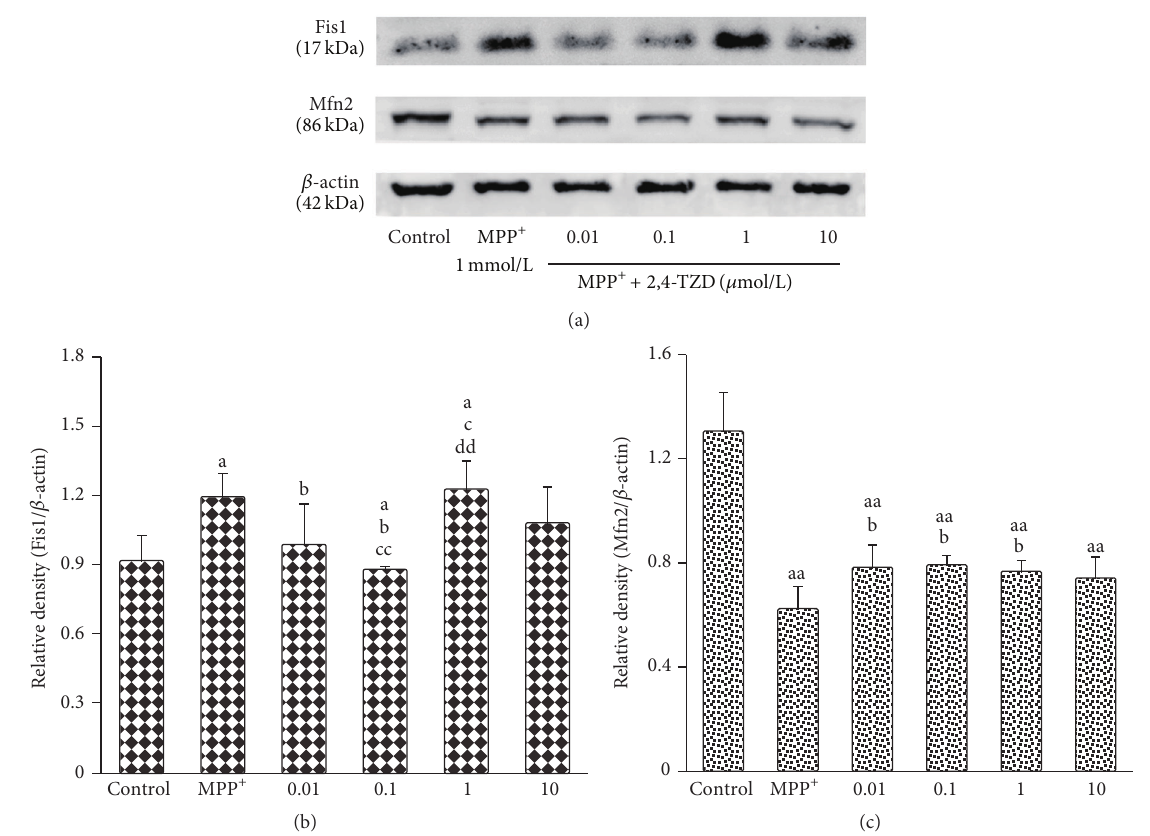
Figure 6: Effect of thiazolidinedione on mitochondria fission and fusion. (a) The expression of Fis1 and Mfn2 in different groups; 𝛽 -actin was used as the loading control. (b) and (c) express the protein level of Fis1 and Mfn2. “a” indicates 𝑃 < 0.05 and “aa” indicates 𝑃 < 0.01 , compared with control group; “b” indicates 𝑃 < 0.05 , compared with MPP + group; “c” indicates 𝑃 < 0.05 and “cc” indicates 𝑃 < 0.01 , compared with 0.01 𝜇 mol/L 2,4-TZD group; “dd” indicates 𝑃 < 0.05 , compared with 0.1 𝜇 mol/L 2,4-TZD